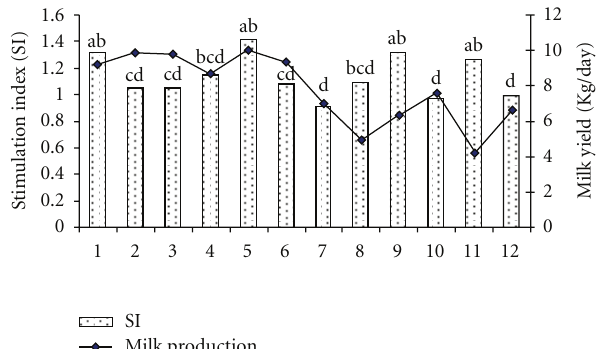
Figure 1: Mitogen-induced stimulation index in bu ff aloes exhibiting di ff erent levels of milk production. Values are mean ± SEM. Bars with values in di ff erent groups that lack a common letter are significantly di ff erent ( P < . 05).